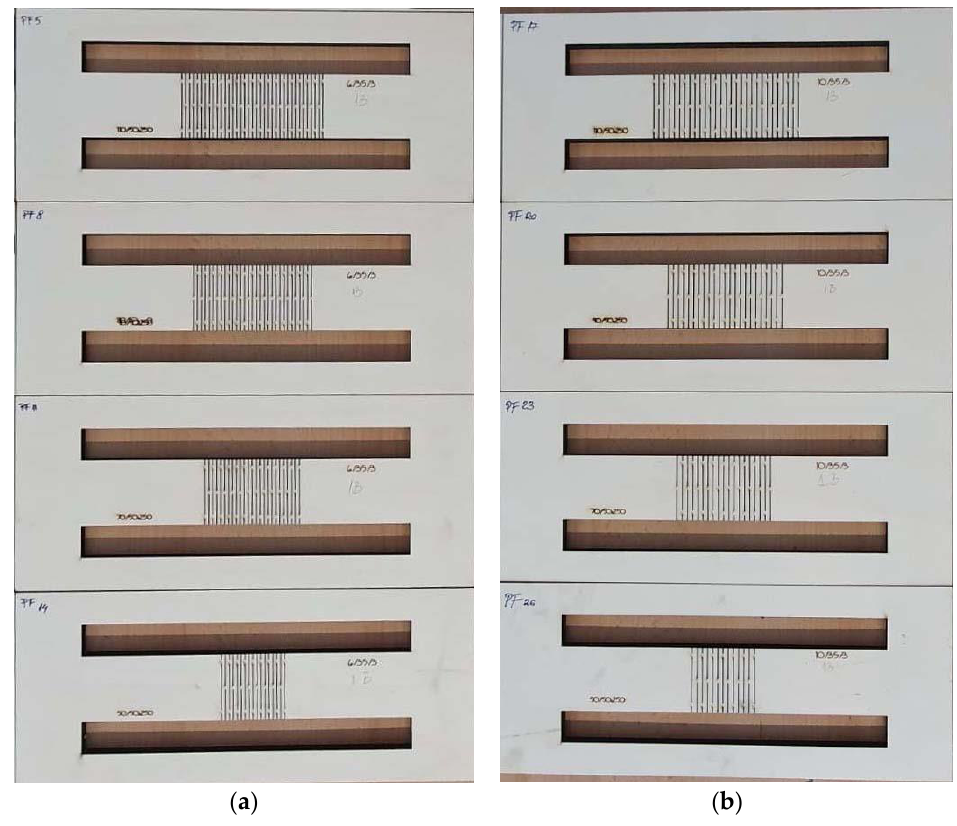
Figure 2. Framed flexible samples, for four flexibilization lengths, from bottom to top (50, 70, 90, and 110 mm) and two values of the kerfing pitch: ( a ) 6 mm; ( b ) 10 mm.